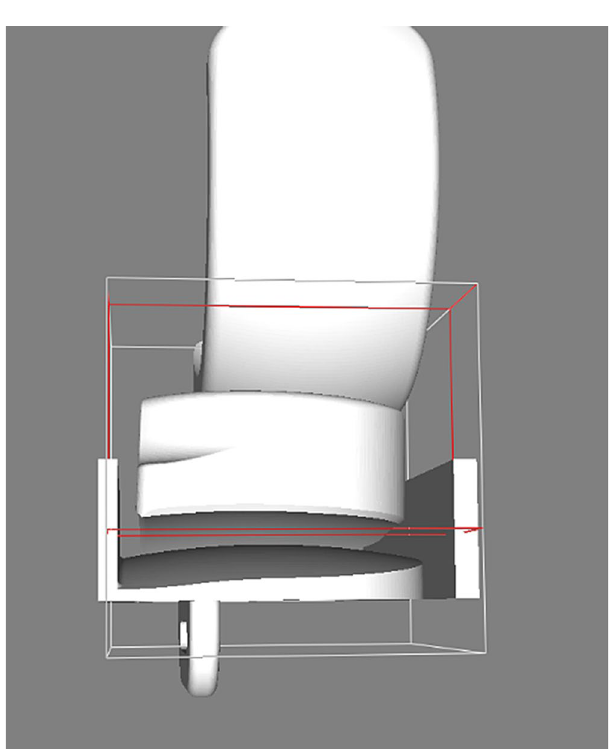
Figure 2. GUI setup showing mobile bearing dislocation with bounding boxes (white outline), goal area (red outline) for dislocation directions: ( a ) medial, ( b ) lateral, ( c ) anterior or ( d ) posterior dislocation. The top panel shows top view and the side view is shown in the bottom panel.